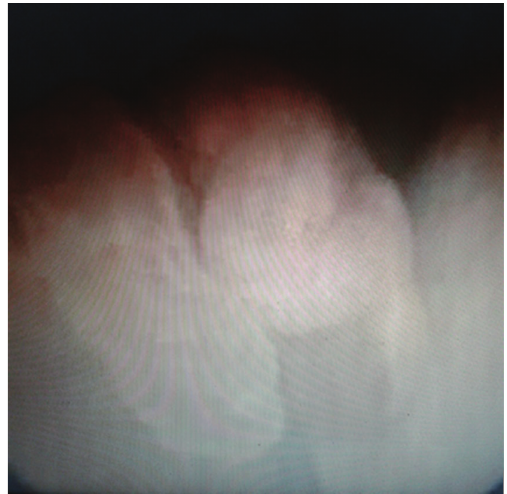
Figure 4: Specimen: reddish-beige tissue (8 × 4 × 1cm in size) containing papillary projections on surface as biggest being 2.5 × 2 cm in